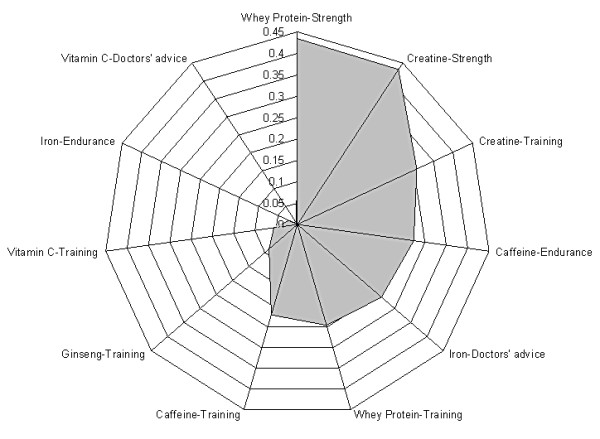
Strength of associations (expressed as phi coefficients) for the selected 9 pairs. Strength of associations are categorized as strong (ϕ > .7), intermediate (.7 < ϕ > .3) and weak (ϕ < .3).